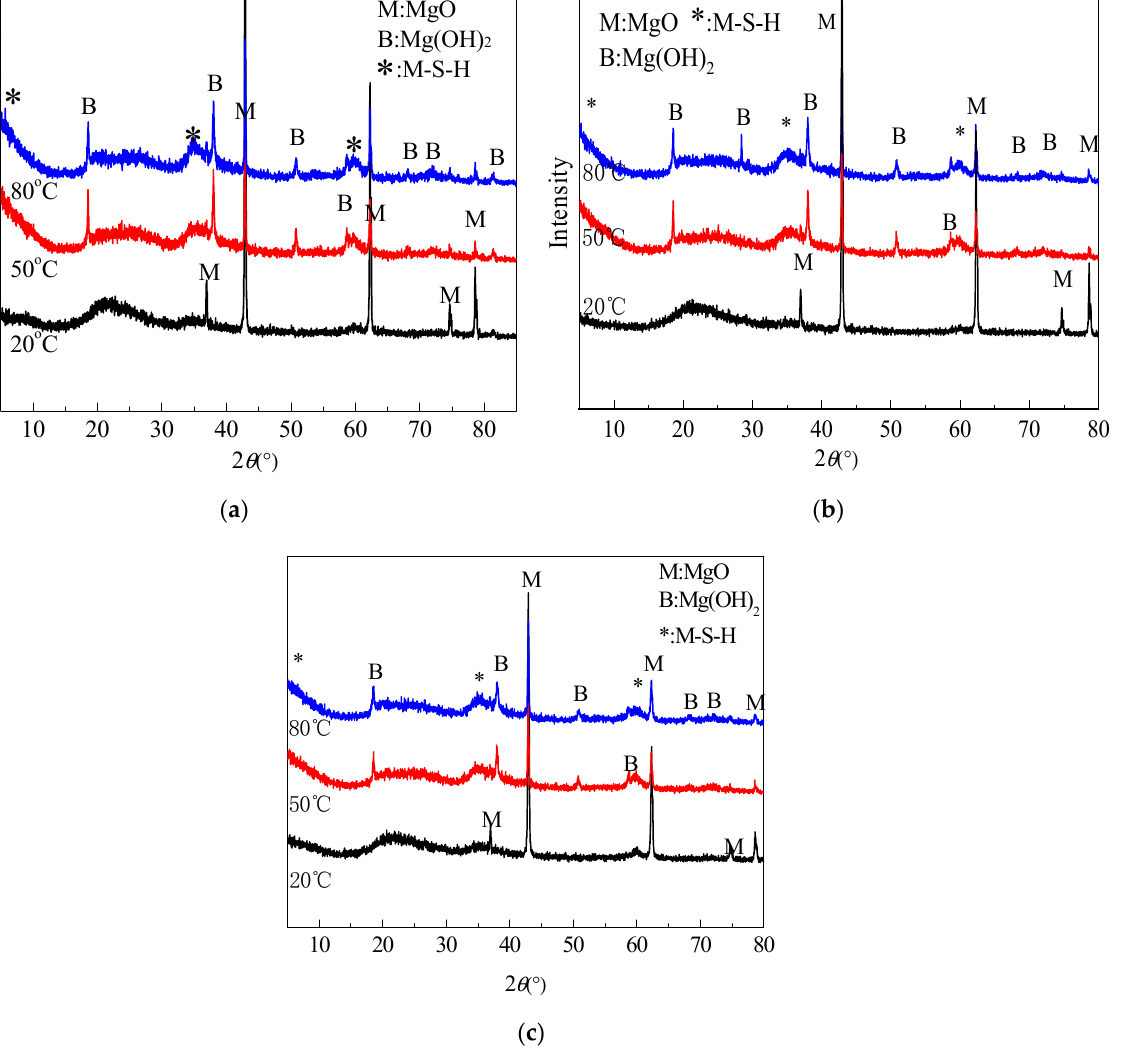
Figure 9. XRD patterns of MgO-SF pastes using MgO calcined at 1450 °C for 2 h: ( a ) cured for 7 d; ( b ) cured for 14 d; and ( c ) cured for 28 d.